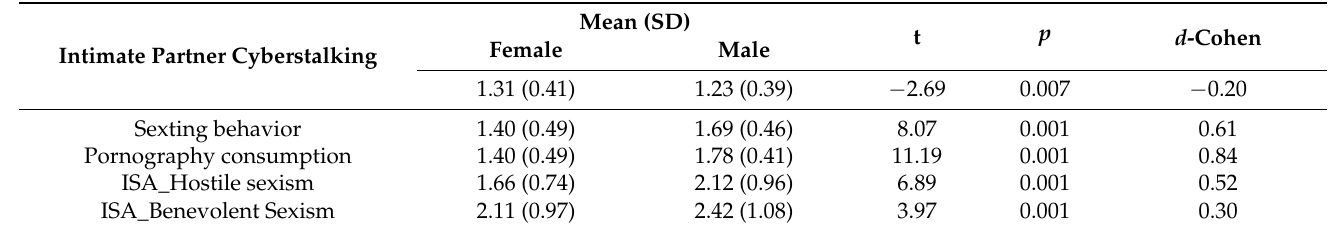
Table 1. Differences in the means of scales/subscales by gender.